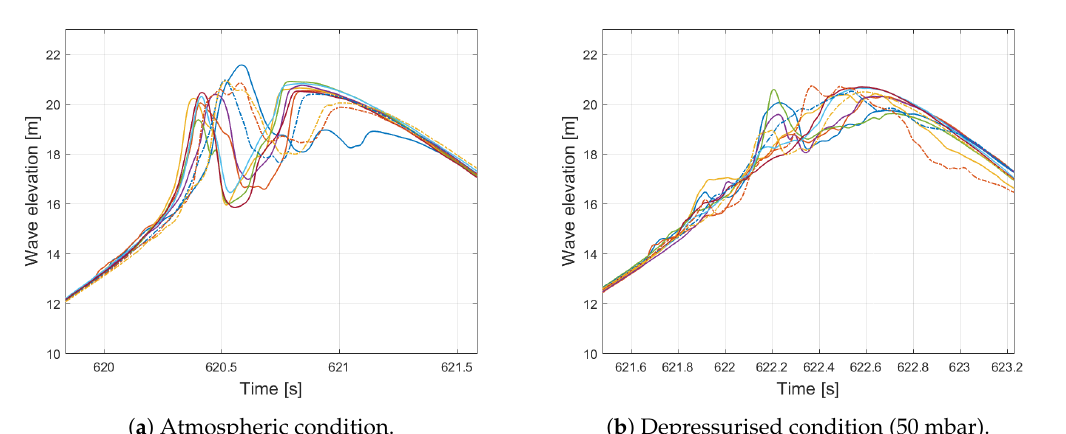
Figure 22. Repeatability of focused Wave 4 at scale 50 in atmospheric and depressurised